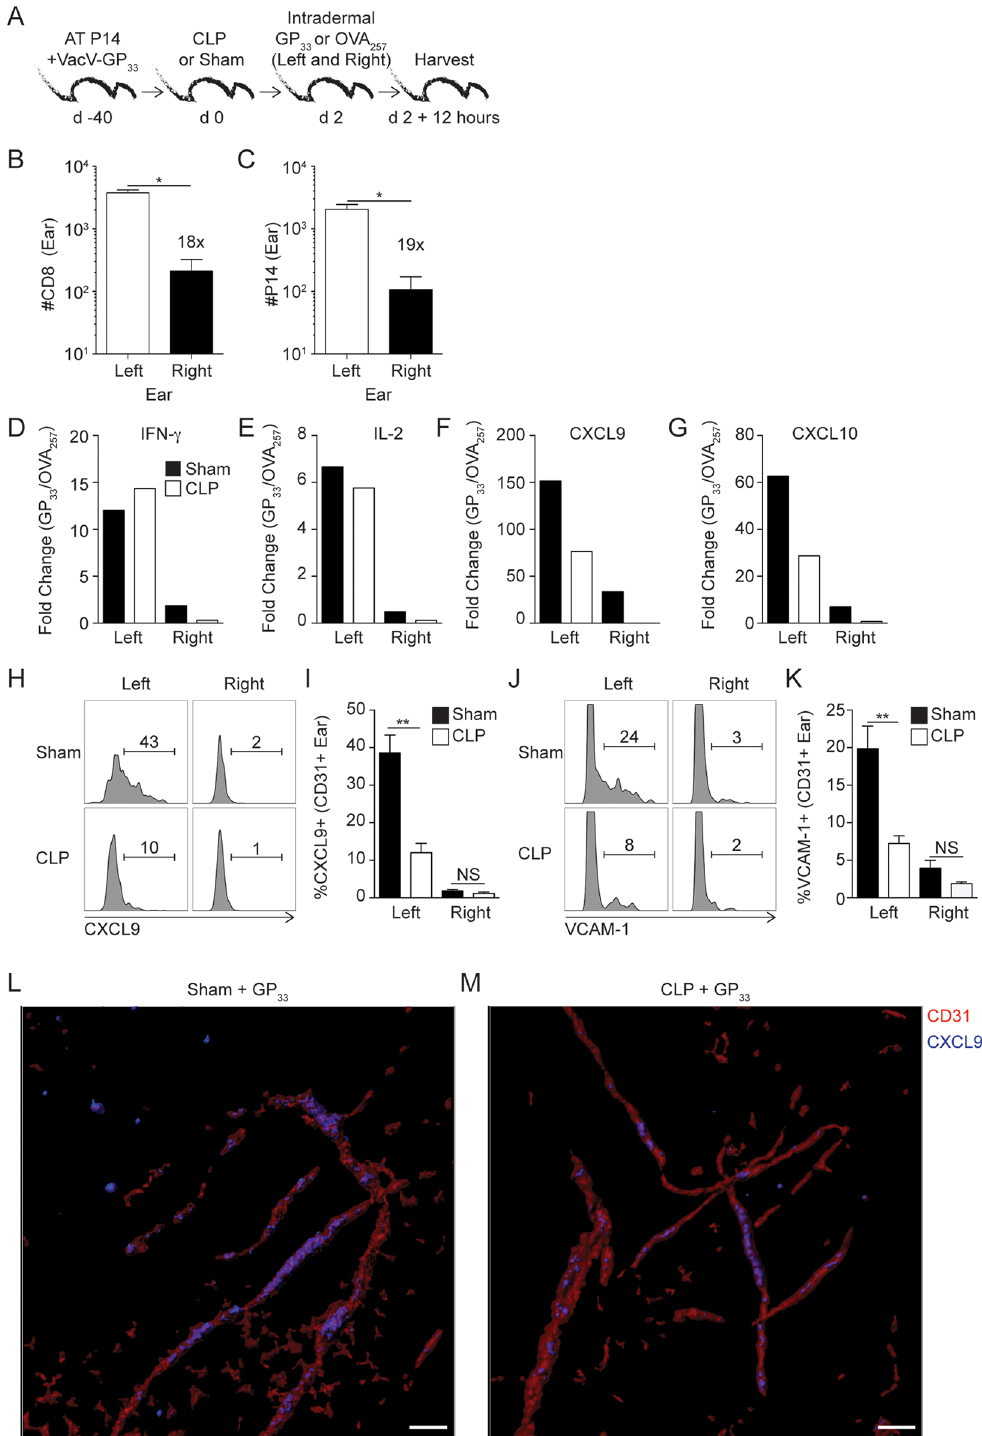
Fig 7. Sepsis impairs endothelial cells capacity to upregulate molecules that promote bystander recruitment in response to skin T RM activation. (A) Experimental Design. 8x10 3 na ï veP14 CD8 T cells (Thy1.1) were adoptivelytransferred into C57Bl/6recipienthosts (Thy1.2) followedby VacV-GP 33 infectionof the left ear. After 40 days mice underwent CLP or sham surgery. One group of mice receivedintradermalinjectionof 50 μ gof GP 33 while second group of mice were injectedwith 50 μ gOVA 257 peptidein both ears (left ear—primary and right